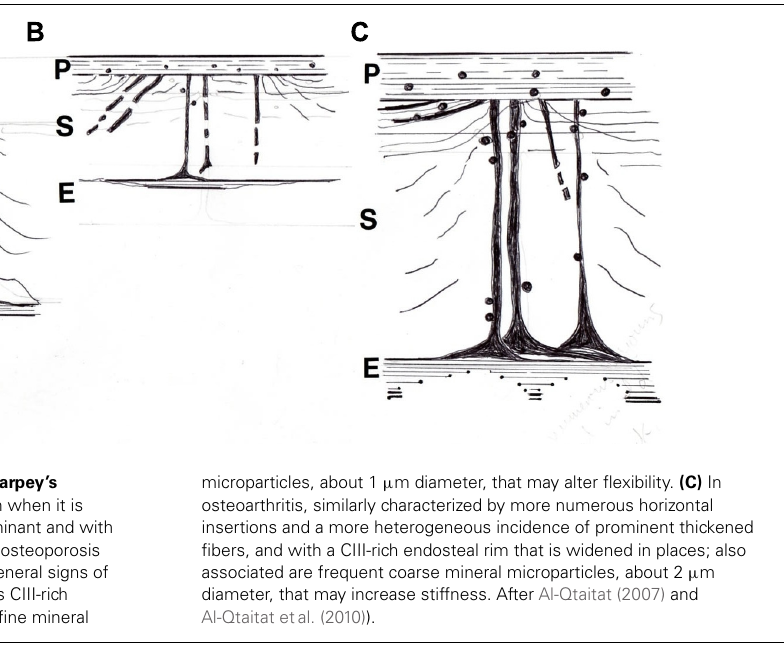
microparticles, about 1 μ m diameter, that may alter flexibility. (C) In osteoarthritis, similarly characterized by more numerous horizontal insertions and a more heterogeneous incidence of prominent thickened fibers, and with a CIII-rich endosteal rim that is widened in places; also associated are frequent coarse mineral microparticles, about 2 μ m diameter, that may increase stiffness. After Al-Qtaitat (2007) and Al-Qtaitat etal.